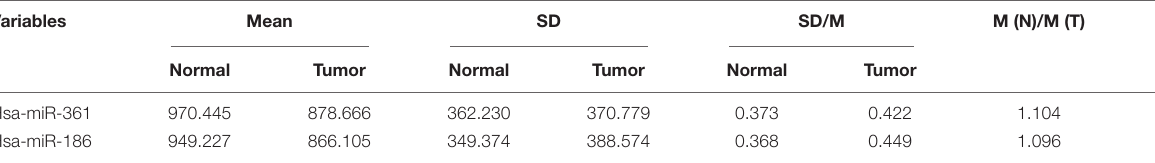
TABLE 1 | Selection of internal reference miRNA.